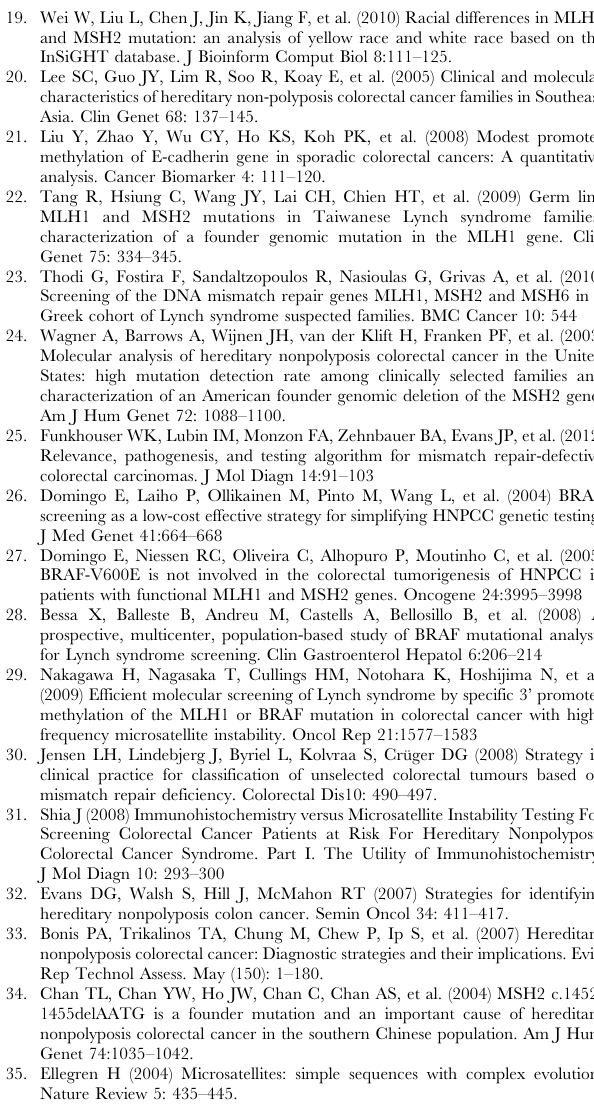
Table S1 Amsterdam I and II criteria, Revised Bethesda guidelines and Japanese criteria for Lynch Syndrome. Table S2 Variants of uncertain significance (VUS) and poly- morphisms in Singaporean Amsterdam-defined